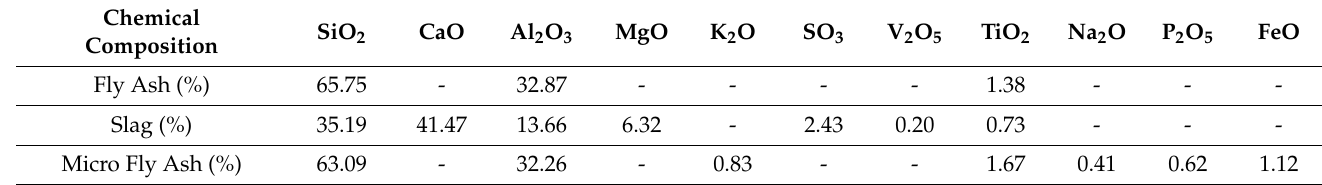
Table 2. Chemical composition (percentage by weight) of fly ash, slag, and micro fly ash